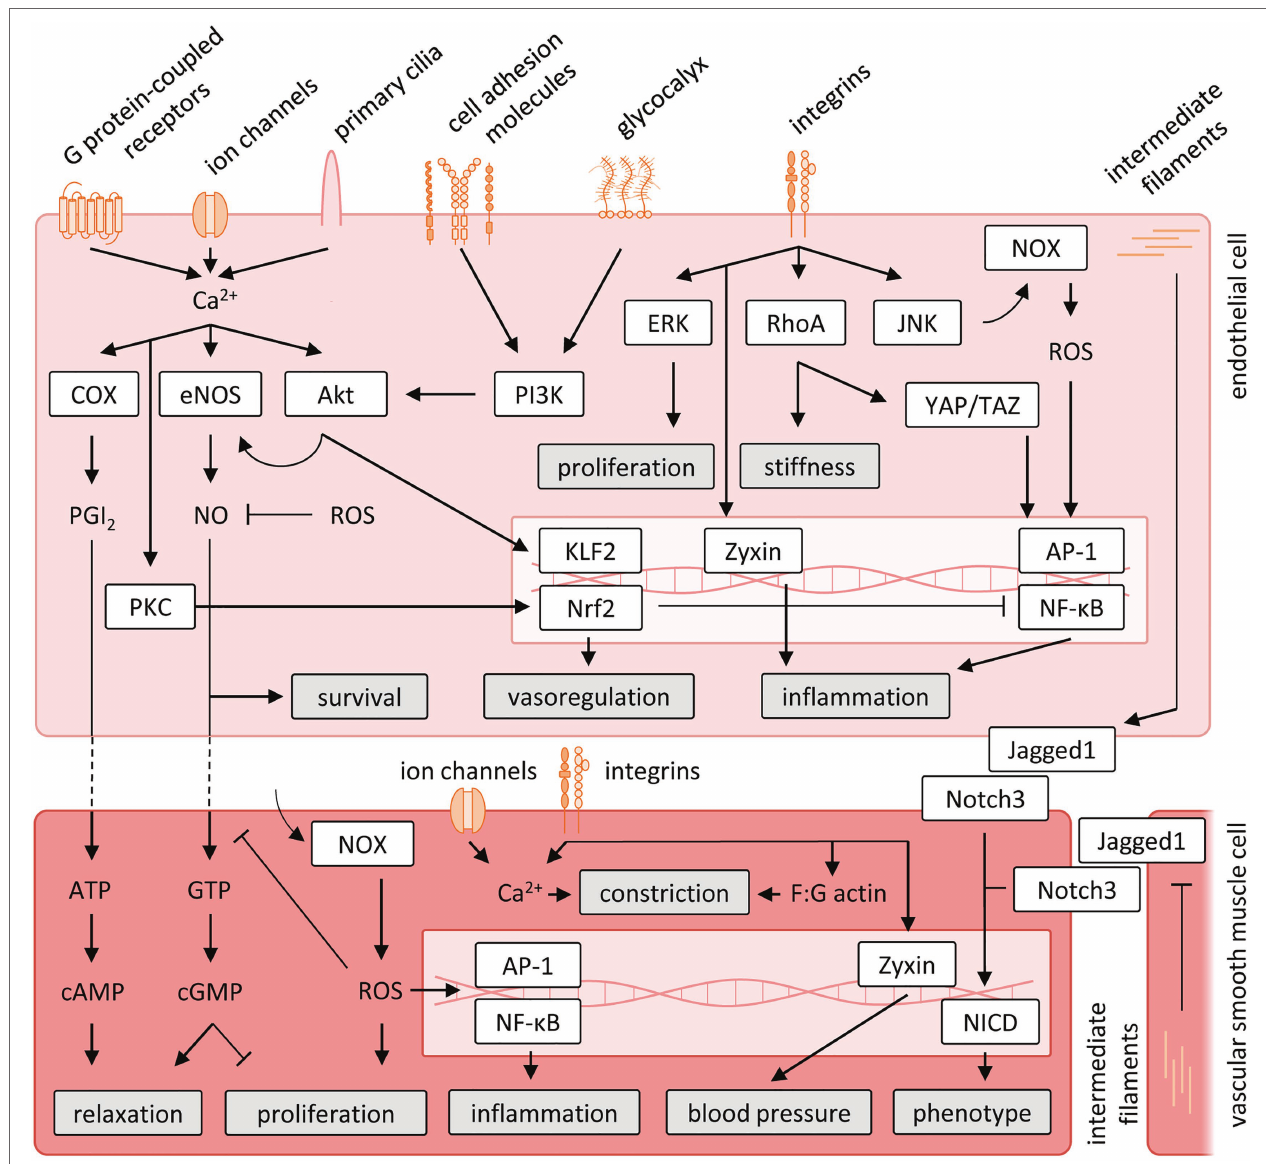
FIGURE 3 | Schematic representation of vascular mechanosensing and signal transduction cascades. Akt, protein kinase B; AP-1, activator protein 1; ATP, adenosine triphosphate; cAMP, cyclic adenosine monophosphate; cGMP, cyclic guanosine monophosphate; COX, cyclooxygenase; eNOS, endothelial nitric oxide; ERK, extracellular signal-regulated kinases; GTP, guanosine triphosphate; JNK, jun N-terminal kinase; KLF2, krüppel-like Factor 2; NF- κ B, nuclear factor- κ B; NOX, nicotinamide adenine dinucleotide phosphate oxidase; NO, nitric oxide; Nrf2, nuclear factor erythroid 2-like 2; PGI 2 , prostacyclin; PI3K, phosphatidylinositol 3-kinase; PKC, protein kinase C; RhoA, Ras homolog family member A; ROS, reactive oxygen species; YAP/TAZ, yes-associated protein/transcriptional coactivator with PDZ- binding